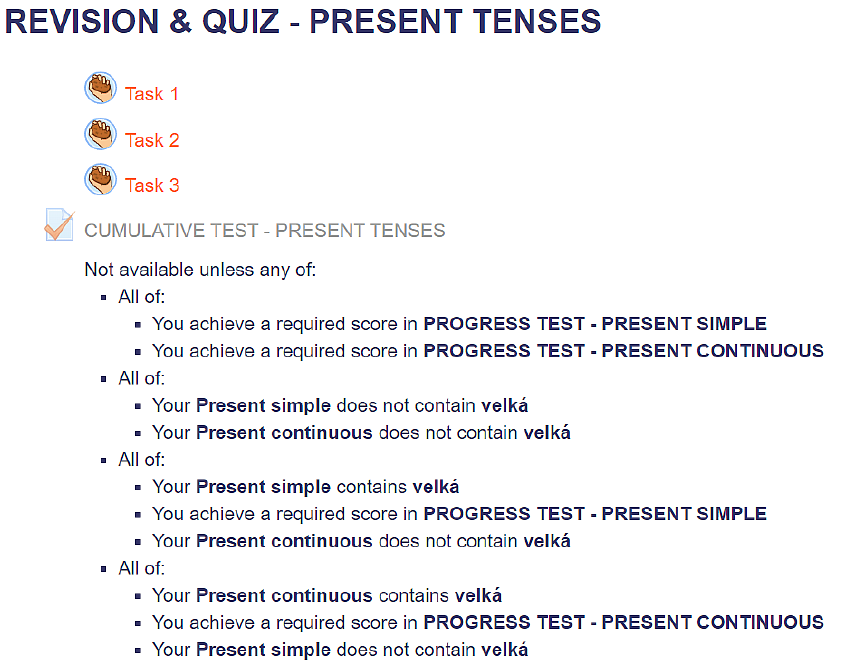
Figure 10. Conditional restriction of a Cumulative test.